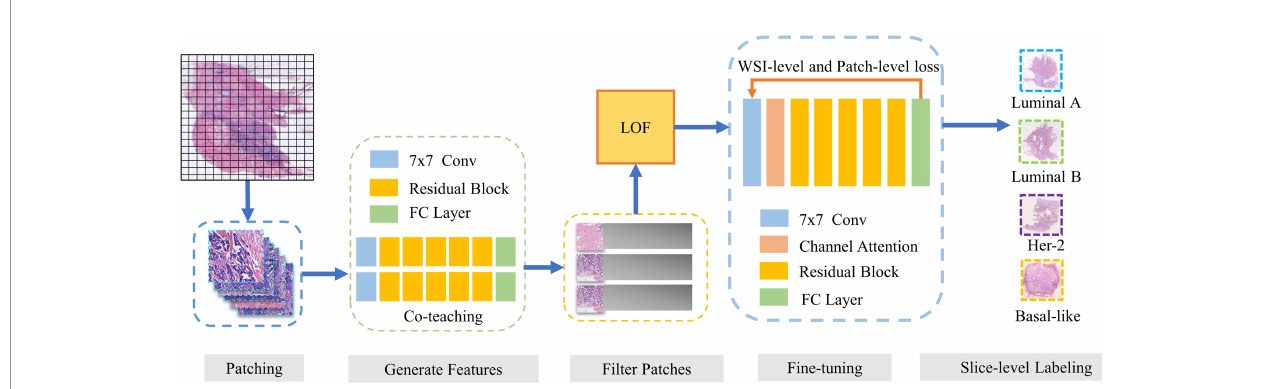
FIGURE 1 | Our framework DPMIL for molecular subtype prediction. The pipeline of out framework contains 5 stages. (1) WSIs are divided into patches. (2) ResNet trained with Co-teaching generate feature for each patch. (3) LOF is adopted to select discriminative patches based on features. (4) Discriminative patches are used to fi netune ResNet with WSI and patch loss. (5) Finetuned model predict fi nal molecular subtypes for patches